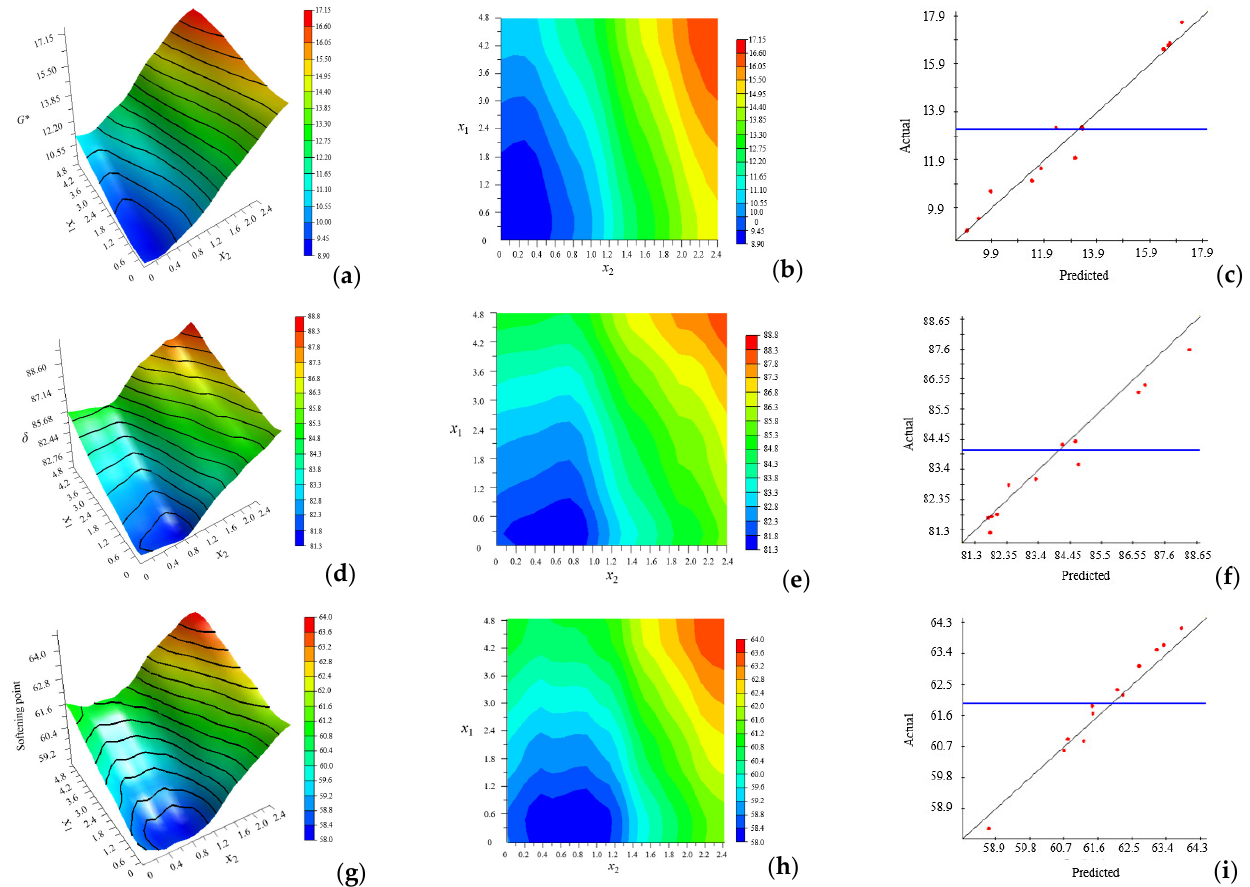
Figure 8. Partial-approximation model, contour plot, and R-squared accuracy of output and input. ( a ) Partial-approximation model of G*, ( b ) Contour plot of G*, ( c ) R-Squared accuracy of G*, ( d ) Partial-approximation model of δ, ( e ) Contour plot of δ, ( f ) R-Squared accuracy of δ, ( g ) Partial-approximation model of softening point, ( h ) Contour plot of softening point, ( i ) R-Squared accuracy of softening point.